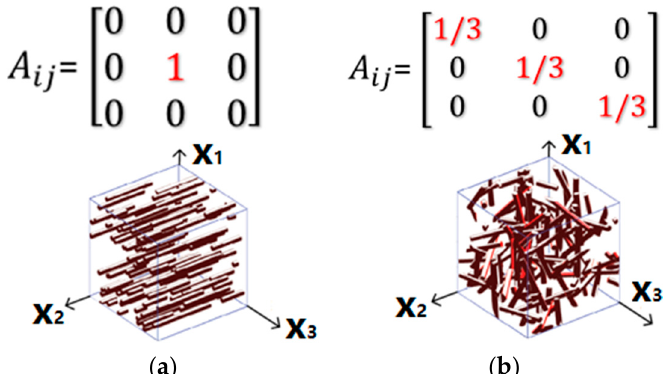
Figure 7. Fiber orientation tensors of ( a ) fully alignment along x 2 direction and ( b ) uniformly random alignment.